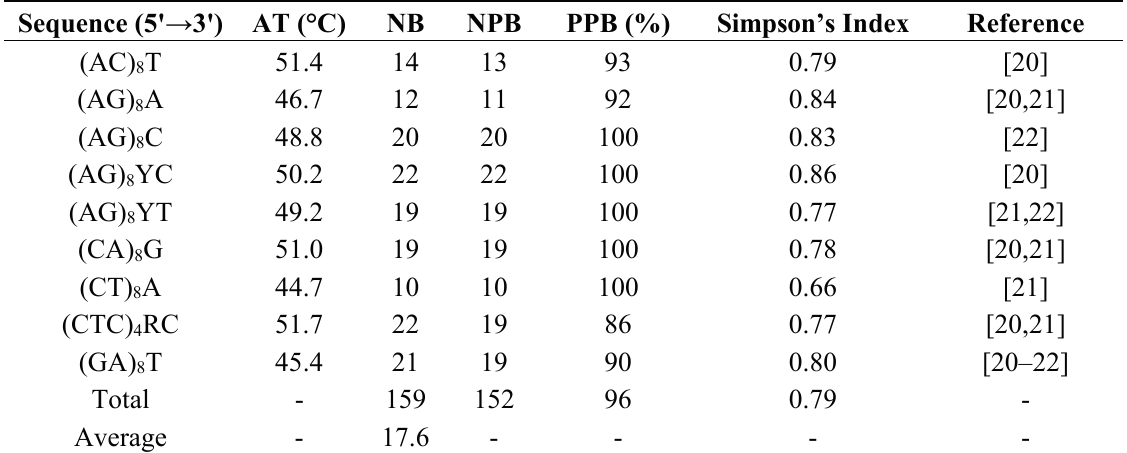
Table 1. ISSR primers used in the analysis of Salvia lachnostachys Benth. (Lamiaceae). Sequence (5' →